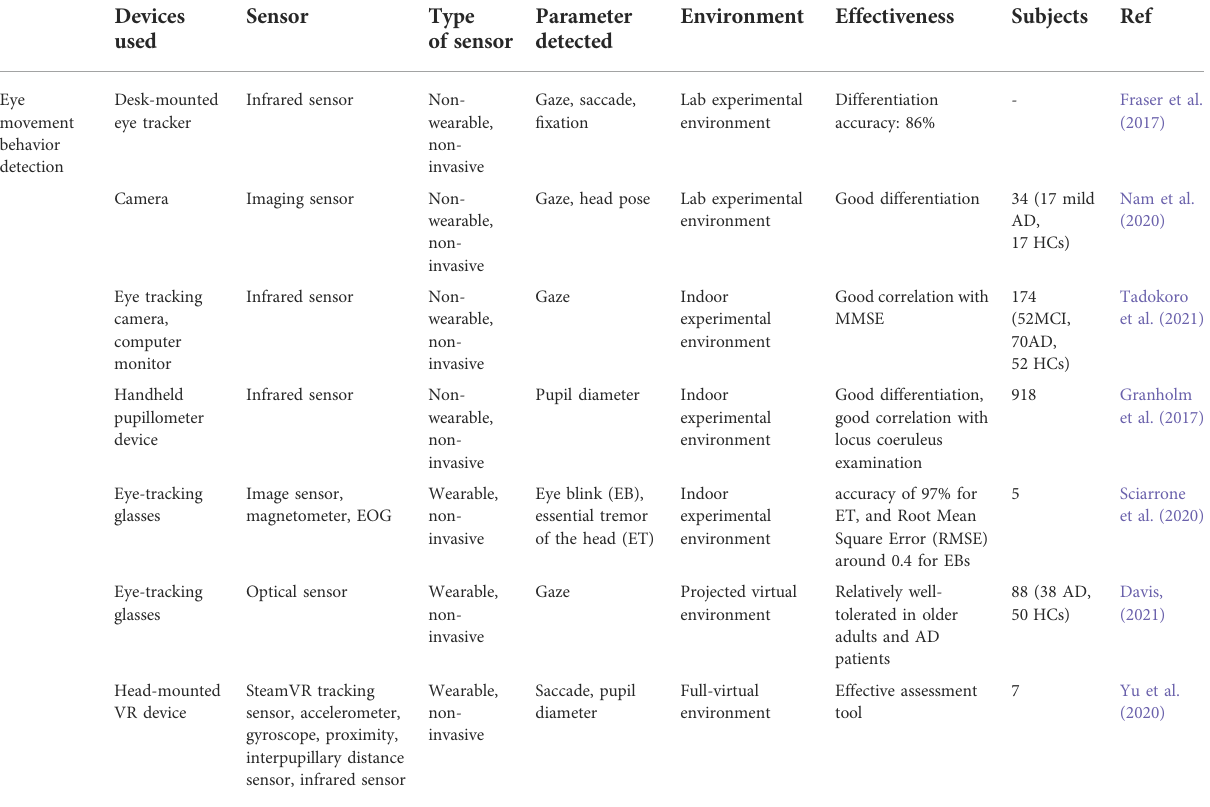
TABLE 2 List of sensor-based eye movement behavior detection toward AD